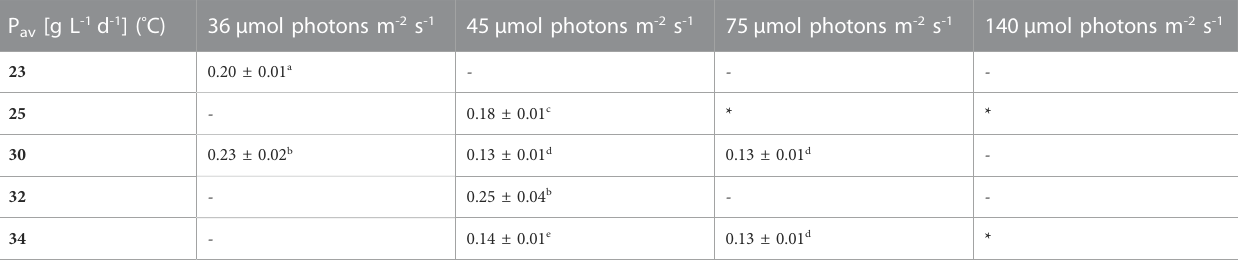
TABLE 2 Overview of the average biomass productivity in the different growth conditions. P av is the slope of the linear regression in the linear growth phase, the values are shown as mean ± CI(95%) of four to eight cultures.